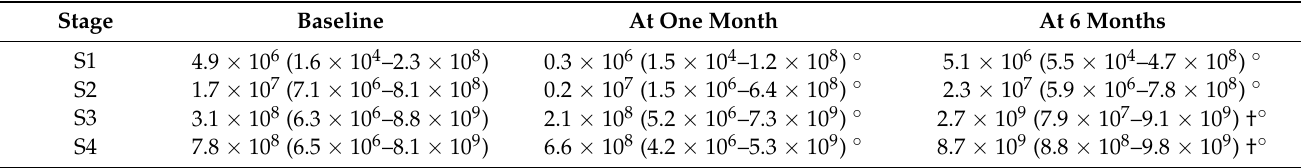
Table 6. Total bacterial load at baseline and at after treatment (one month and six months) in control group (SRP